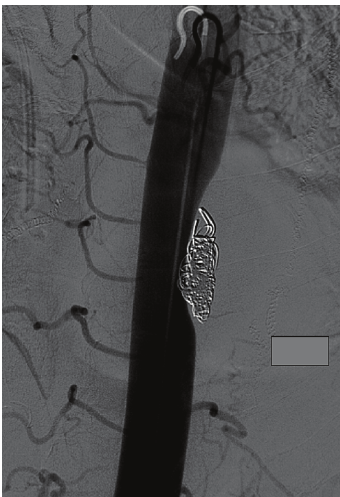
Figure 5: Aortogram, after coil embolization of the T8 intercostal artery. Note that the postcoil embolization aortoagram demon- strates no contrast opacification of the pseudoaneurysm lumen, a coil mass measuring approximately 1 . 5 × 3 . 5 cm, and a gentle regional concave deformity of the aorta, implying that the true lumen of the pseudoaneurysm was larger than what opacified origi- nally.